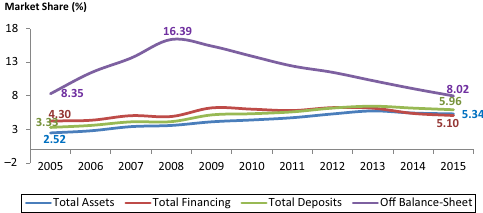
Figure 5. IBs Market shares in assets, fi nancing